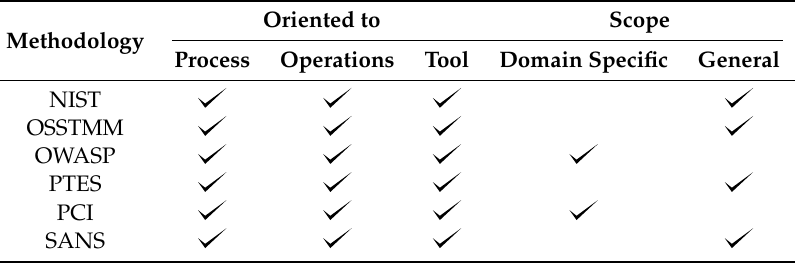
Table 1. Comparative methodology